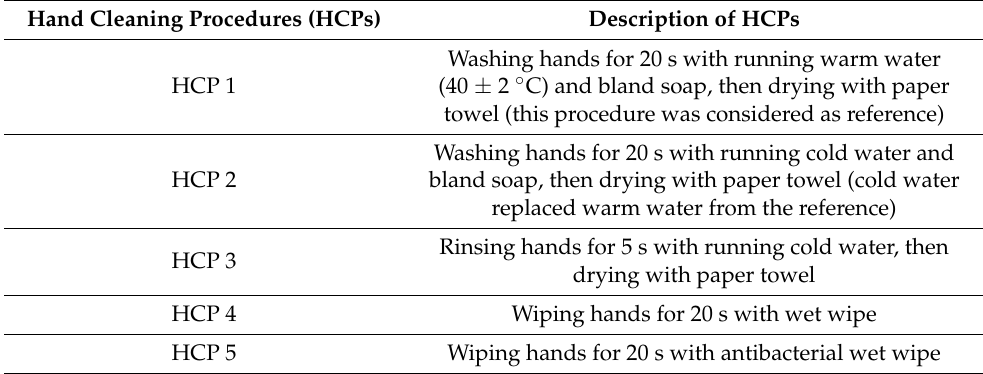
Table 1. Hand-cleaning